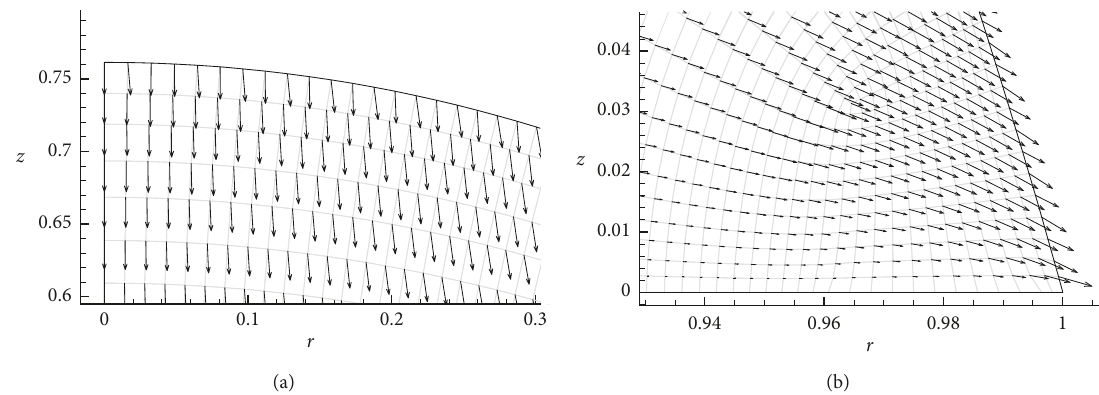
Figure 5: Velocity vectors inside the drop phase at t � 0.014, initial AR � 0.8, and Ca � 8.41 × 10 − 8 : (a) on top of the droplet and (b) at the contact